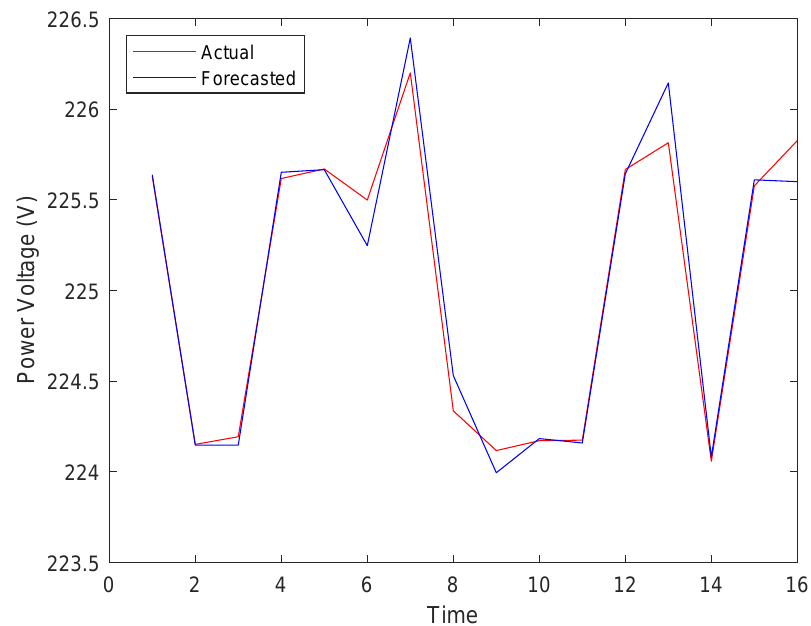
Figure 9. Comparison of actual and forecasted voltage when using